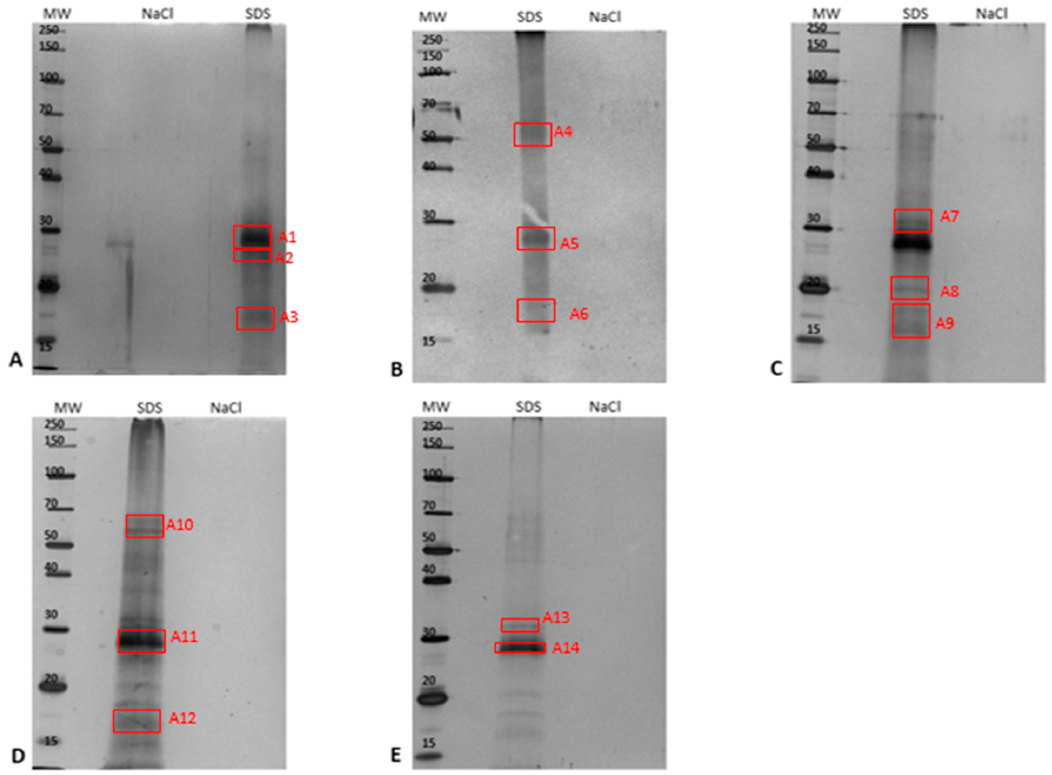
Figure 4. Comparative 12% 1D-SDS-PAGE analysis of ergosterol-interacting candidate proteins eluted with 0.5 NaCl and 1% SDS during the affinity-capture procedure using epoxide magnetic microspheres, where A = control, and B = 0 h-, C = 6 h-, D = 12 h-, and E = 24 h-treated samples. For each fraction, 20 µ g total protein was loaded and electrophoresed at constant 90 V at room temperature. The red blocks (A1–A14) were excised subsequent to silver staining and analyzed using LC-MS/MS. Table 3. LC-MS/MS identification of A. thaliana PM-associated candidate proteins interacting with ergosterol immobilized on epoxide magnetic microspheres for control, 0-, 6-, 12-, and 24 h subsequent to treatment and listed according to functional categories (Supplementary Data Sheet 3). Sample No.